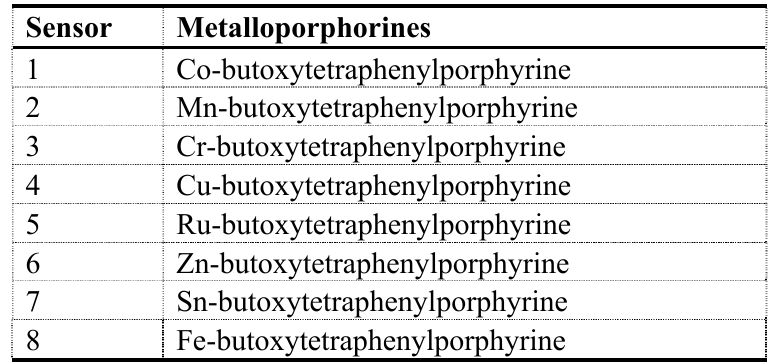
Table 1. Active matrix (metalloporphyrines) used to coat the quartz crystal microbalance sensors of LibraNose 2.1 e-nose